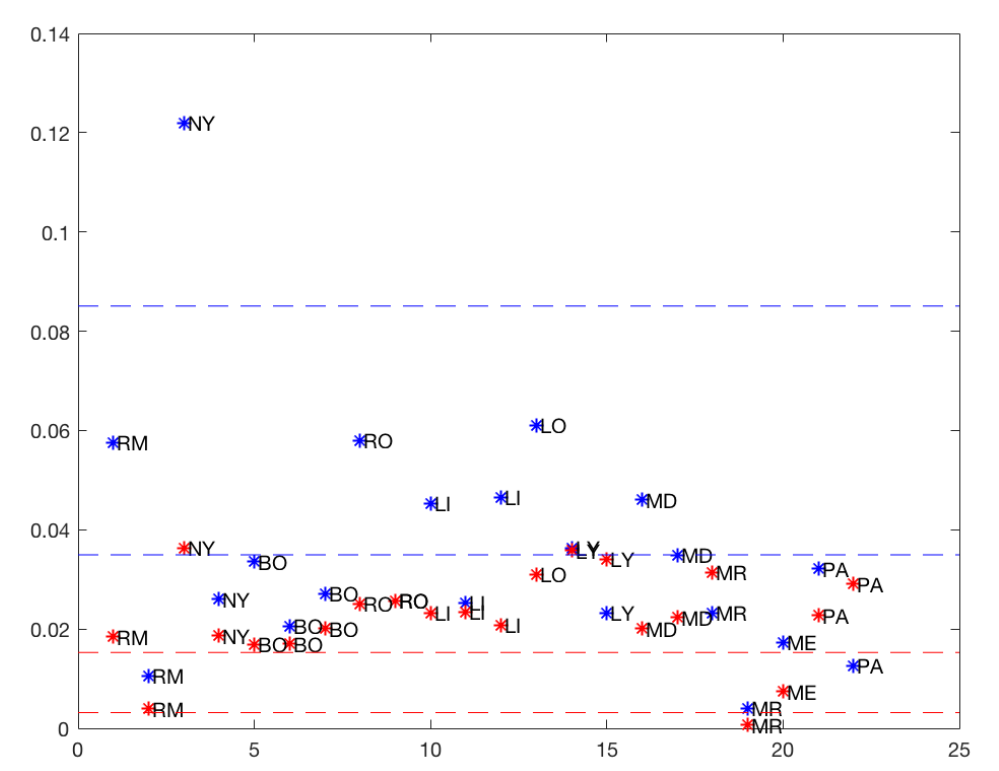
Figure 7. Cluster analysis for rises: blue: total , red: 50 %, (without